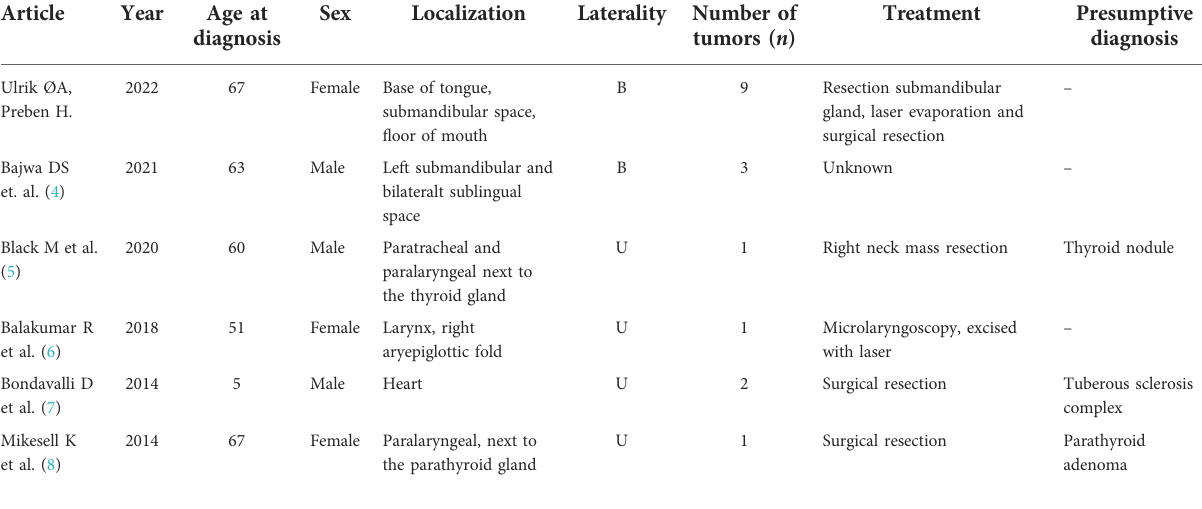
TABLE 1 Table description: overview of the literature